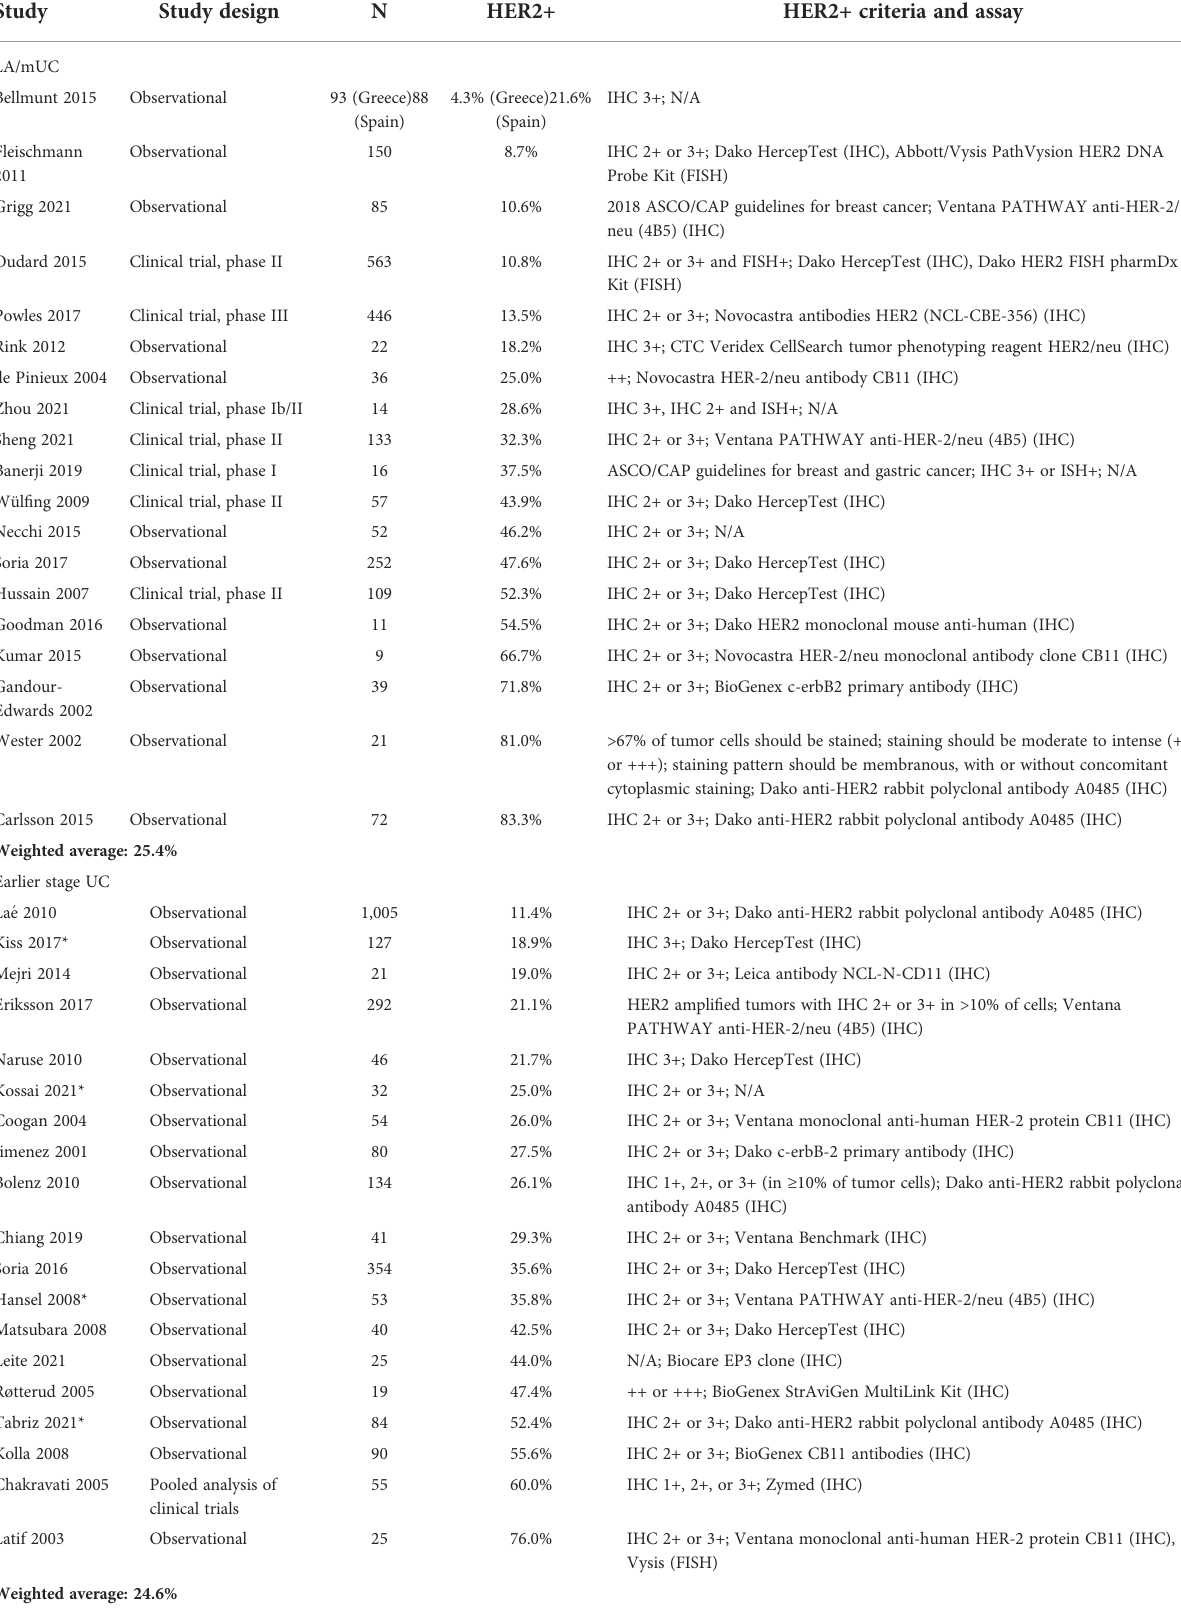
TABLE 4 Overview of HER2+ across all